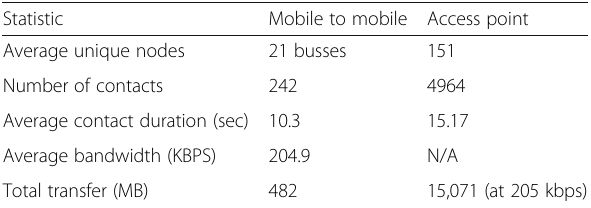
Table 1 Characteristics of mobile to infrastructure and mobile to mobile contacts